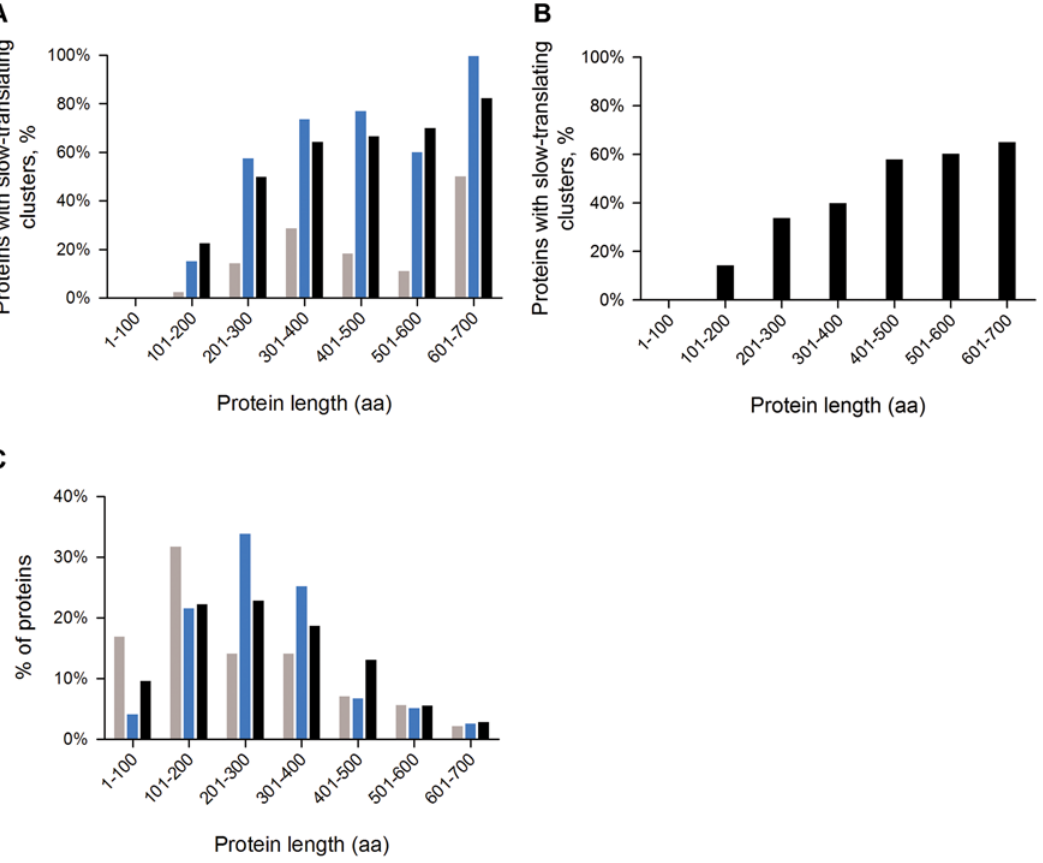
Figure 4. Putative sites for translational attenuation are more frequent in larger proteins. In both E. coli (A) and B. subtilis (B) almost every protein with a length exceeding 300 amino acids has at least one cluster of slow-transating codons (black bars). Note that the initial local minimum at 5 9 -termini due to its abundance is excluded from these calcualtions. From the data set of the E. coli protein abundance (http://redpoll.pharmacy. ualberta.ca/CCDB/), proteins are subdivided into two categories: highly abundant (gray bars) with a copy number higher than 1000 copies/cell and lowly abundant (blue bars) – with a copy numbers lower than 100 copies/cell. C) The dependence of the length distribution on the protein abundance in E. coli is shown as a reference using the same color scheme as in panel A.